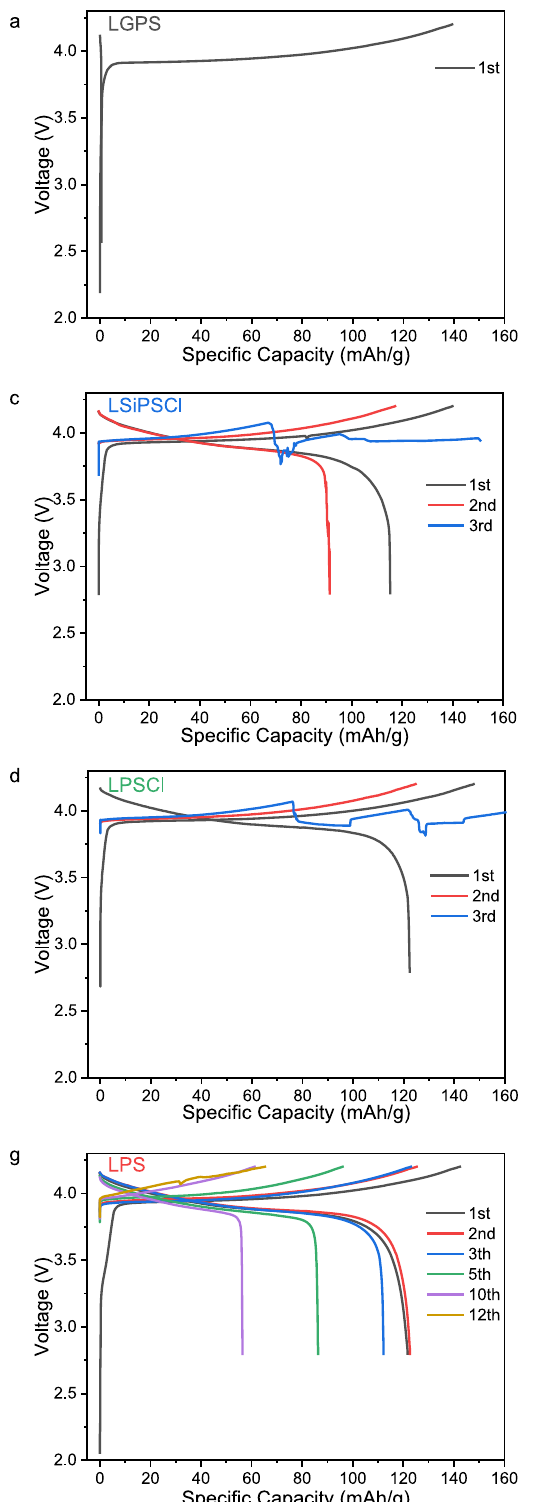
fourcycles).ForthreeelectrodeAFBs(homemademold,similartoSwageloktype), LiCoO 2 was used as the working electrode (WE), a Cu disc was used as the counter electrode (CE) and Li 0.35 In was used as the reference electrode (RE). The cells are cycled at a current density of 0.08mAcm − 2 at 30±2°C with an applied external pressure of 25MPa. The mass of “ speci fi c capacity ” refers to the mass of active material (LiCoO 2 ) in the positive